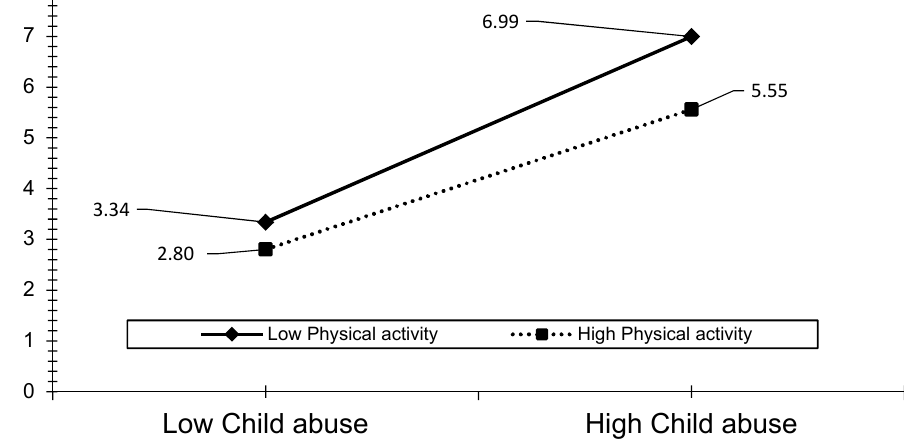
Figure 5. Model 7—Graph of interaction effect between PA and ACE on mentally unhealthy days.